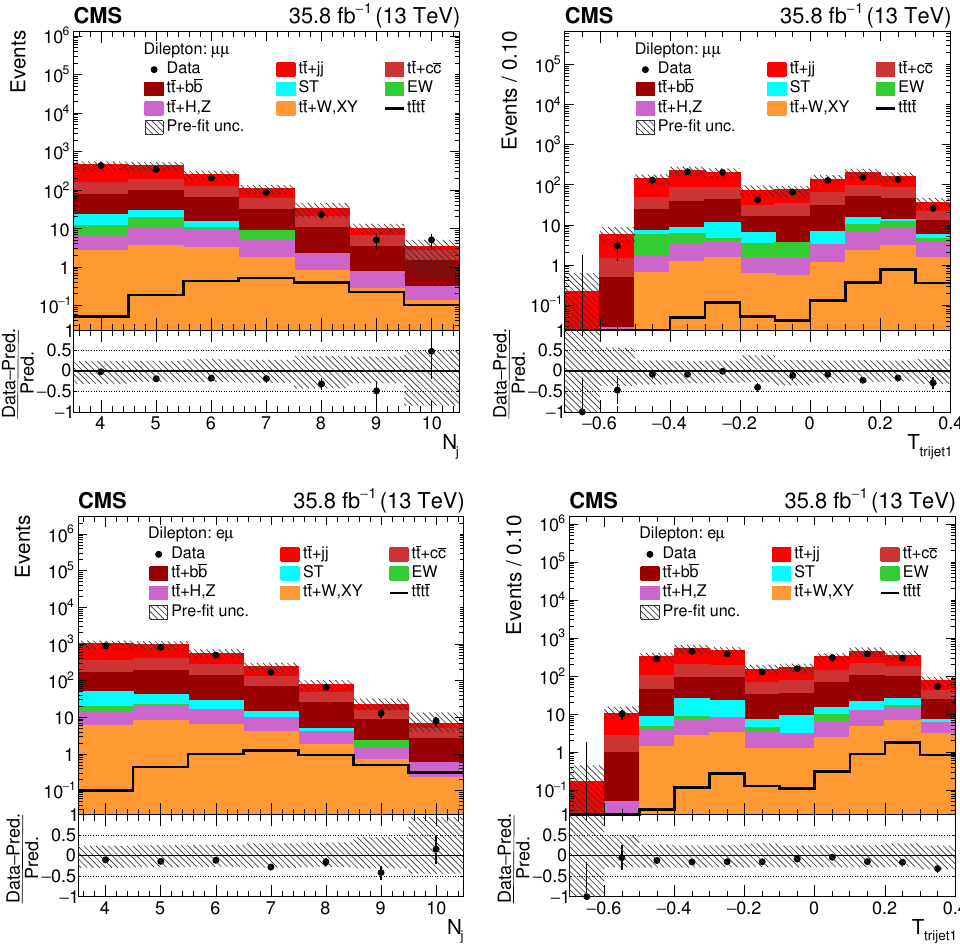
Figure 4 . Distributions of N and T in the (cid:22) + (cid:22) (cid:0) (upper row) and (cid:22) (cid:6) e (cid:7) (lower row) chan- j trijet1 nels. In the upper panels of each (cid:12)gure, the data are shown as dots with error bars representing statistical uncertainties, MC simulations are shown as a histogram. The lower panels show the relative di(cid:11)erence between the data and the sum of all of the standard model backgrounds. In each panel, the shaded band represents the total uncertainty in the dominant tt background estimate. See section 4.2 for the de(cid:12)nitions of the